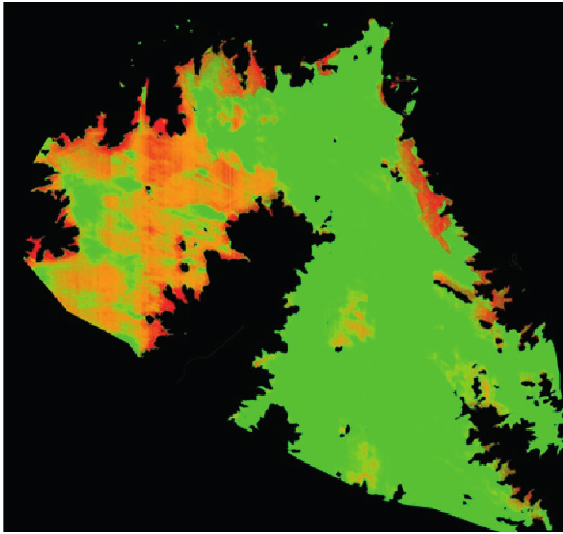
Figure 6 - The processed image from Castanhão reservoir in 2013 showing the increased eutrophication